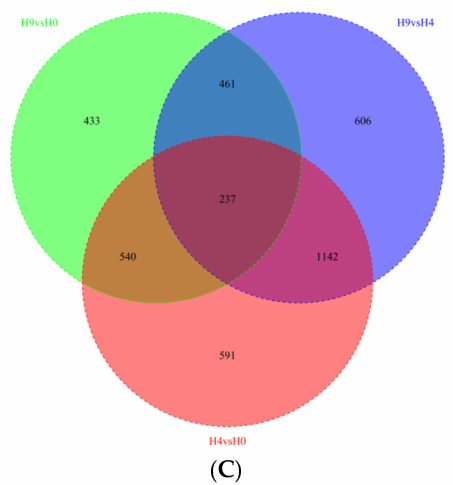
Figure 2. Comparison of differentially expressed genes identified during several adipogenesis stages. ( A ) Volcano Plot analysis of differentially expressed genes (DEGs) in the early stages of adipogenesis; ( B ) volcano Plots analysis of DEGs in the later stage of adipogenesis; ( C ) volcano Plots analysis of DEGs in various stages of adipogenesis.